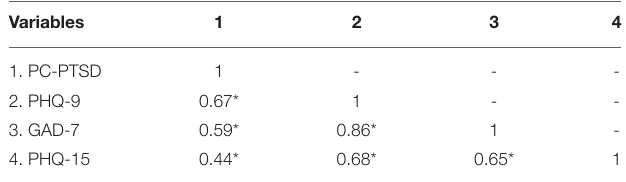
TABLE 2 | Pearson correlation matrix for mental-health-related variables in COVID-19 patients ( n = 118). Variables